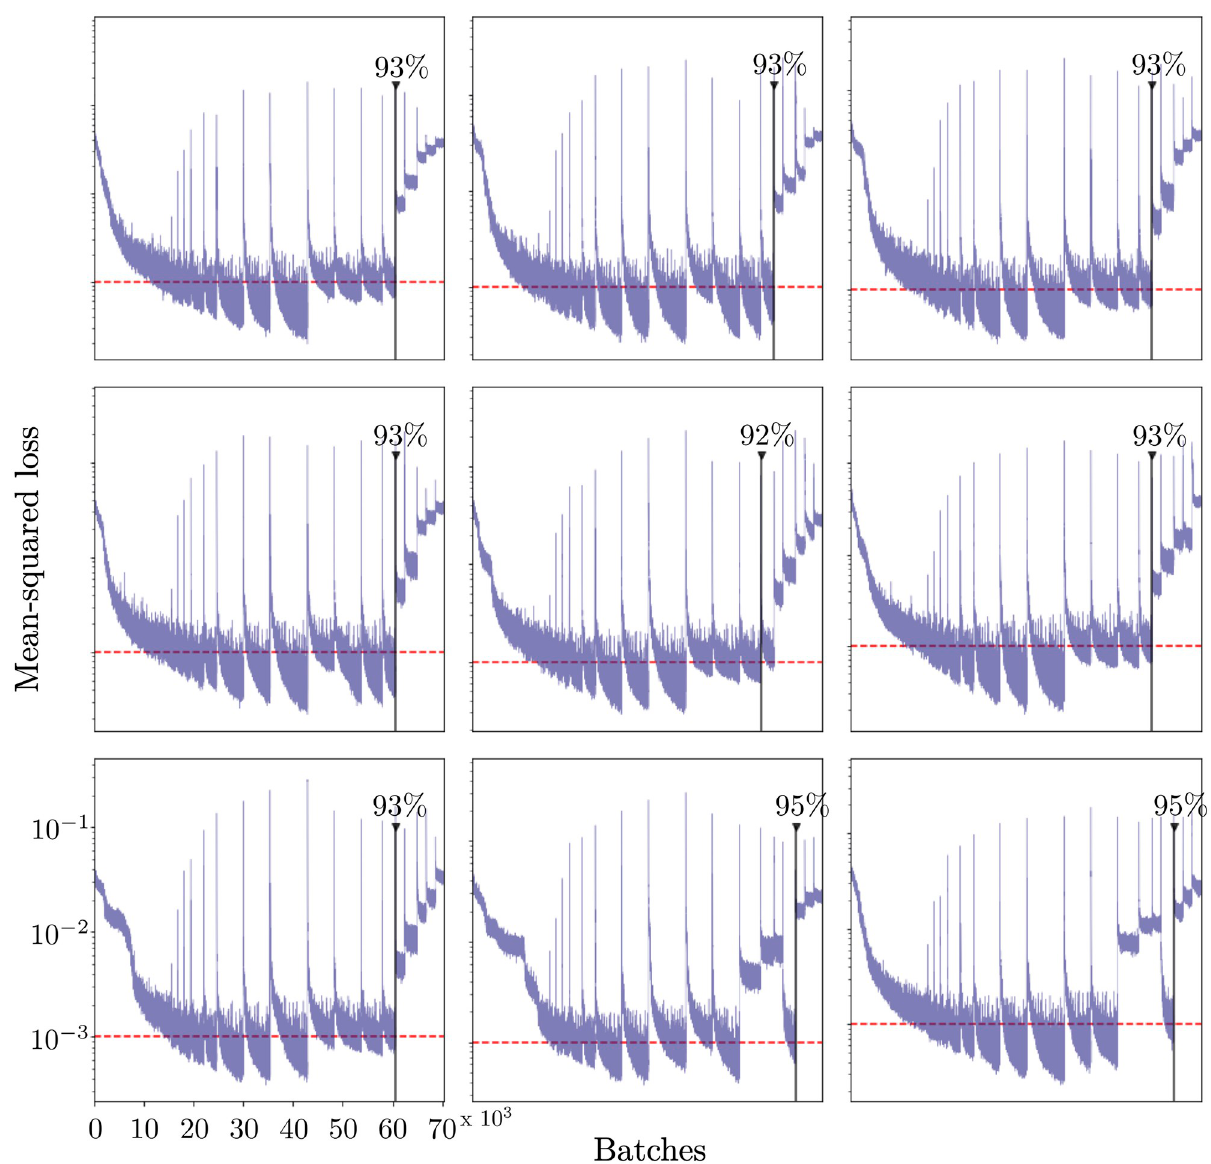
Fig 3. Performance breakdown of 9 sample pruned networks. The networks are sequentially pruned. Each network is evaluated to find the optimally sparse network. The red dashed line represents the performance threshold (10 − 3 ). The sparsest network that performs below this threshold is shown by the solid, black vertical